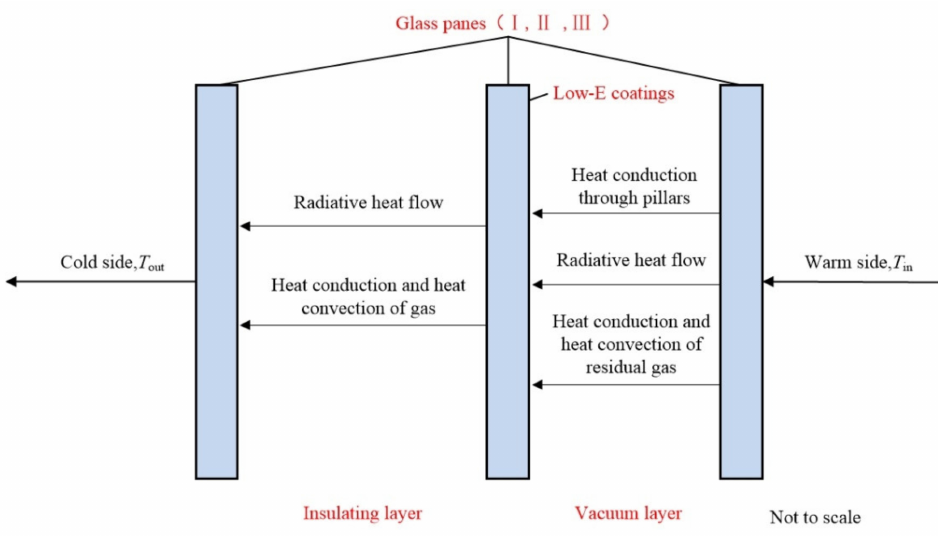
Figure 2. Heat transfer mechanisms in the CVG system.